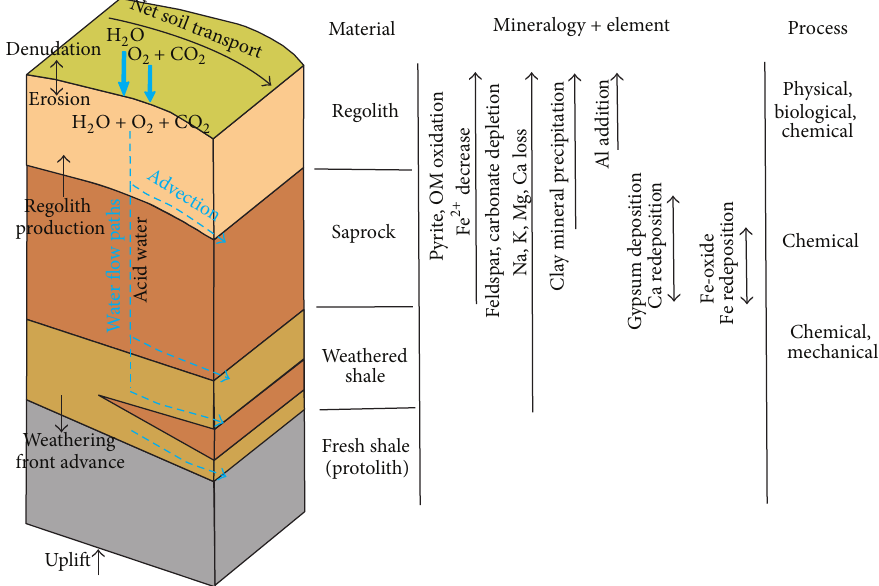
Figure 6: Conceptual weathering model of Shuijingtuo Formation black shale, Lower